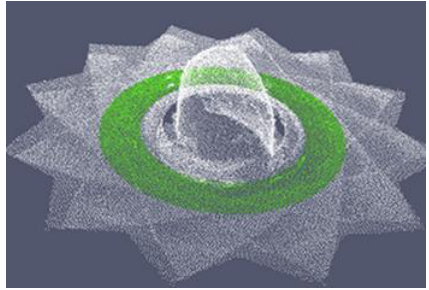
Figure A4. Disk section corresponding to the lower plane of the examination table.